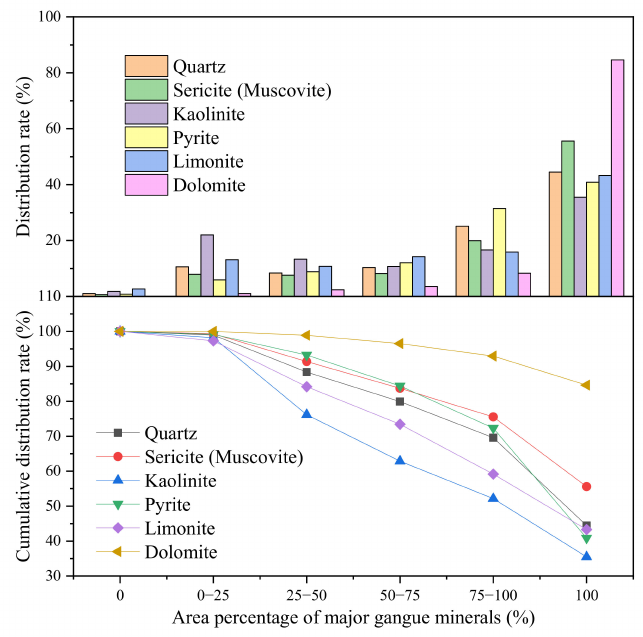
Figure 11. Statistics of mono-mineral liberation degree of major gangue minerals: particle size of 0.52–212 µ m.